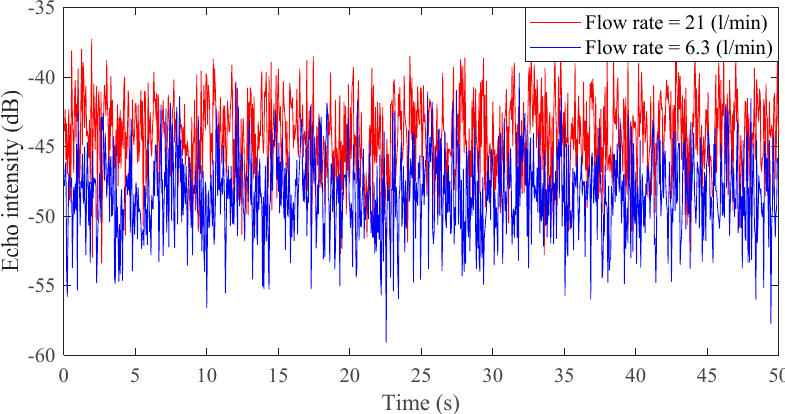
Figure 10. Comparison of echo intensities at two flow rate outputs.